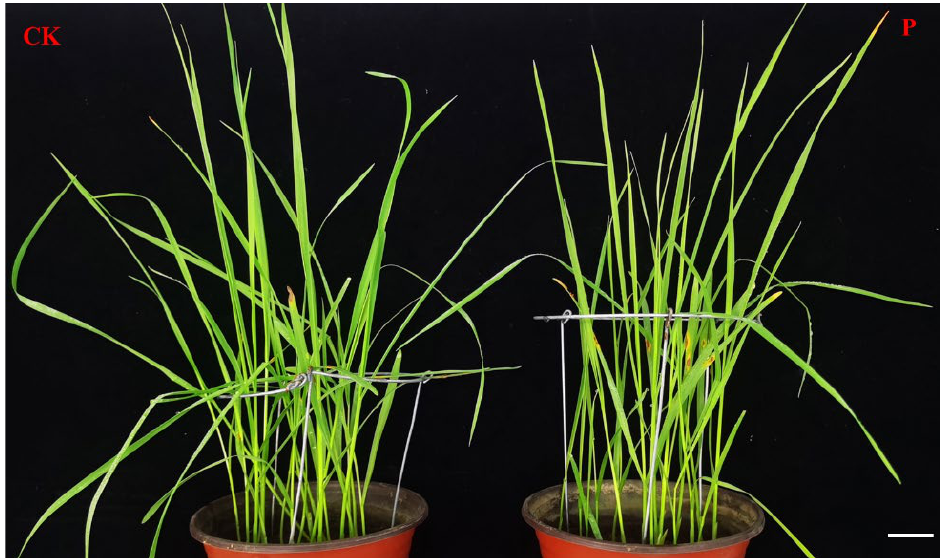
Figure 1. Phenotypes of oat leaves. Scale bar = 1 cm. CK, no Pga inoculation; P, Pga